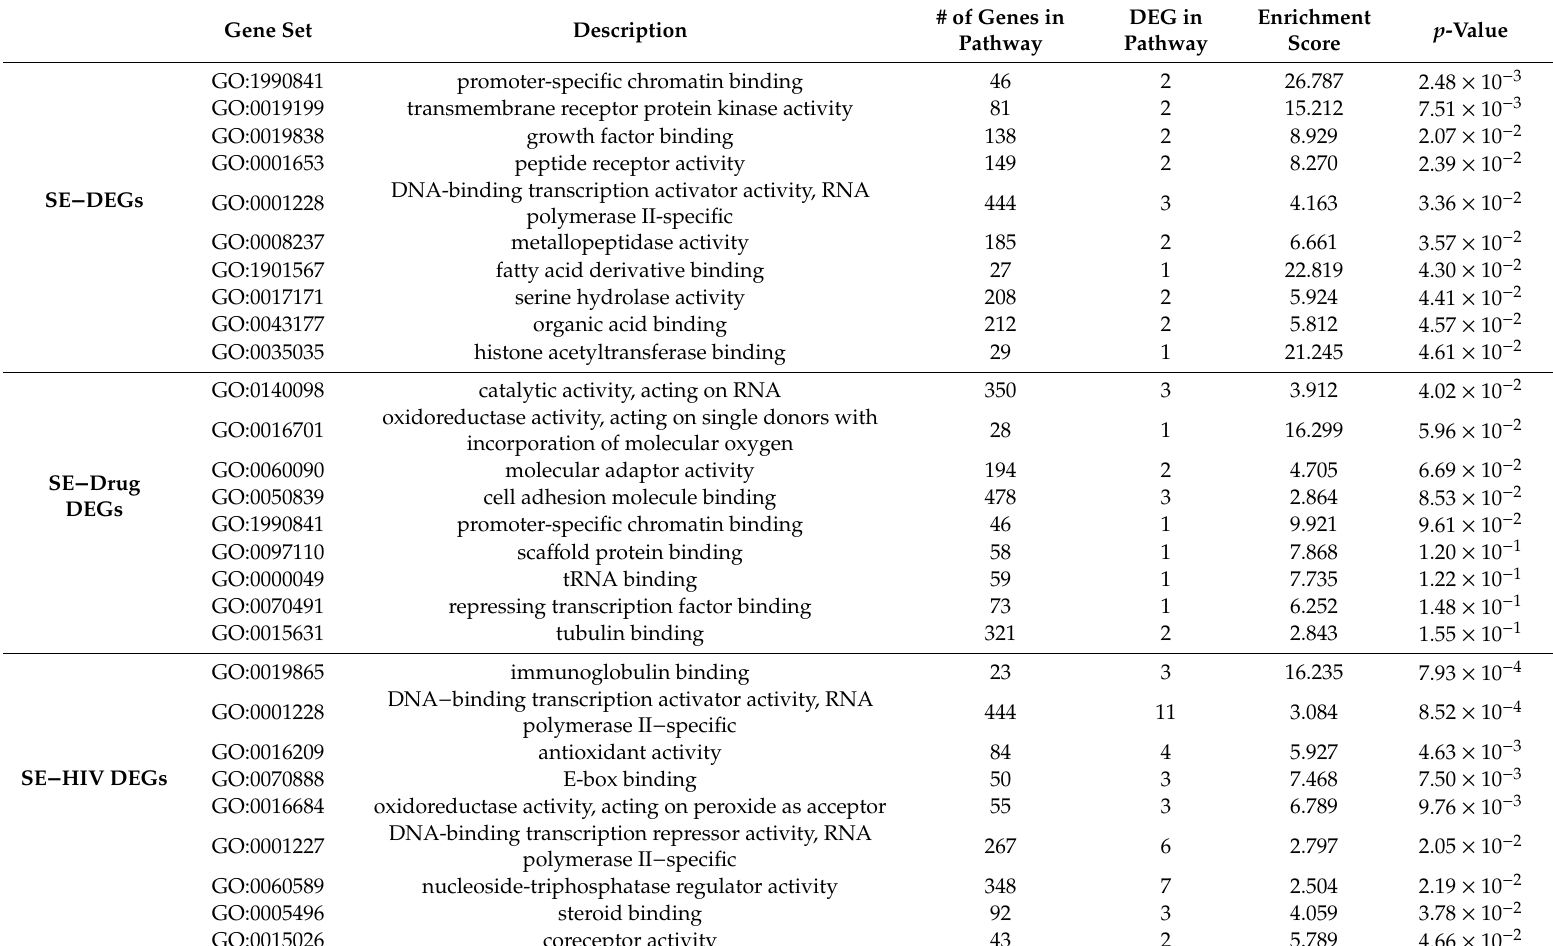
Table 5. Top 10 molecular function GO terms from Webgestalt analysis 1